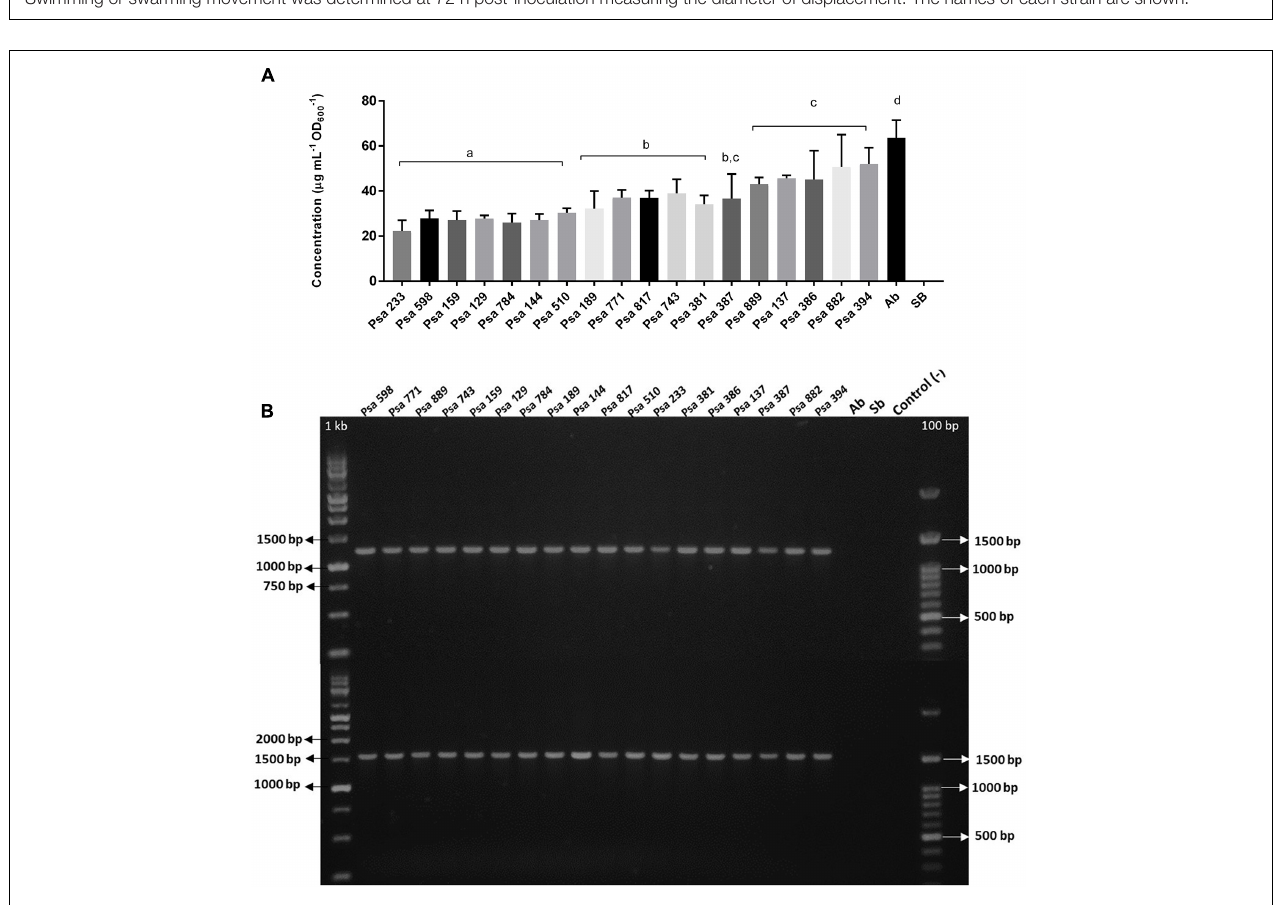
FIGURE 3 | Motility of the Chilean Psa isolates. (A) Swimming or swarming motility of different Chilean Psa strains. (B) Representative image of selected strains. Swimming or swarming movement was determined at 72 h post-inoculation measuring the diameter of displacement. The names of each strain are shown.